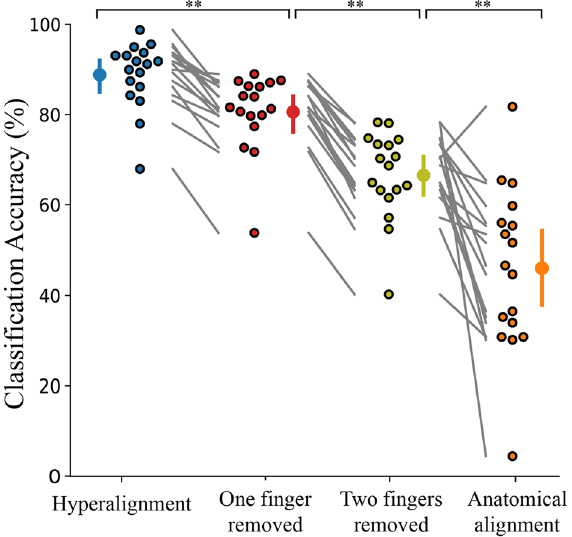
Figure 5. Overall classification accuracy for all four fingers when all fingers are included in hyperalignment parameter calculations (88.8%), when one finger is removed during hyperalignment (80.6%), when two fingers are removed during hyperalignment (66.5%), and anatomical alignment with all fingers included (46.0%). Individual participants are presented beside the mean as circles with a black outline. Error bars indicate a 95% confidence interval. ** p <